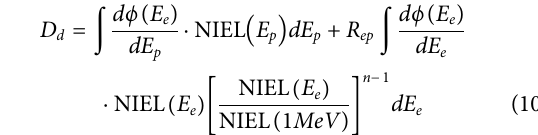
Frontiers in Physics |